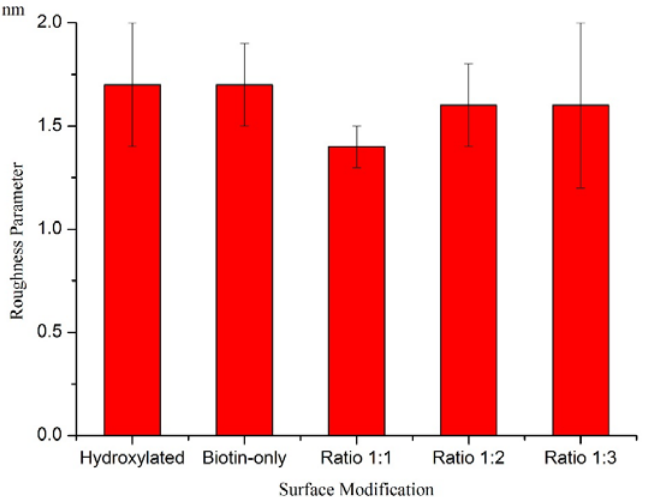
Figure 9. Mean Roughness Parameters (±standard deviation) of functionalized wafers after lysozyme adsorption. Three spots were measured on each wafer with optical profilometry, and three wafers were examined for each group. The addition of PEG to the surface appears to slightly reduce the overall roughness, although the initial surfaces are very